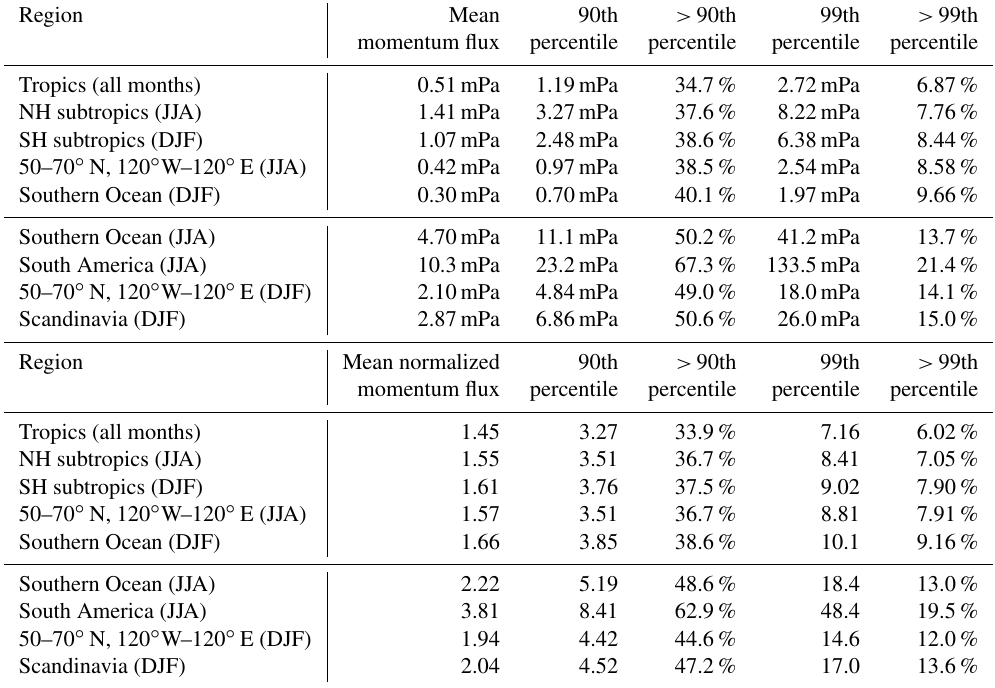
Table 3. Means, 90th percentiles, and 99th percentiles as well as fractions of gravity wave absolute momentum fluxes at values beyond the respective percentiles for the PDFs of momentum fluxes (upper part of the table) and normalized momentum fluxes (lower part of the table) shown in Figs. 7 and